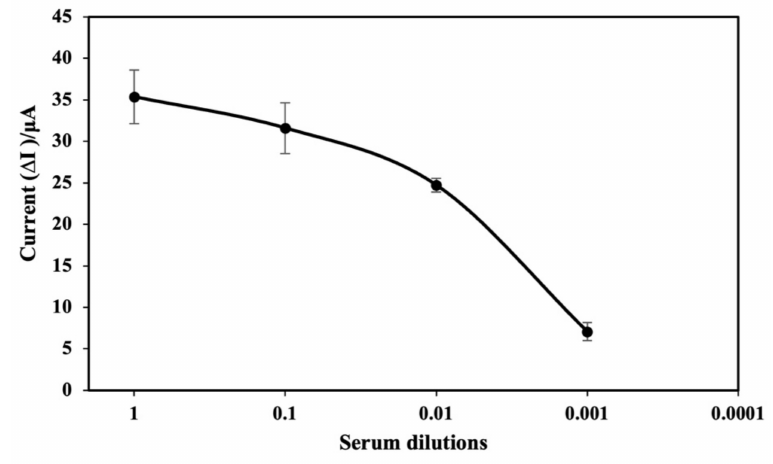
Figure 10. Evaluation of optimal serum dilution for spike recovery assay.